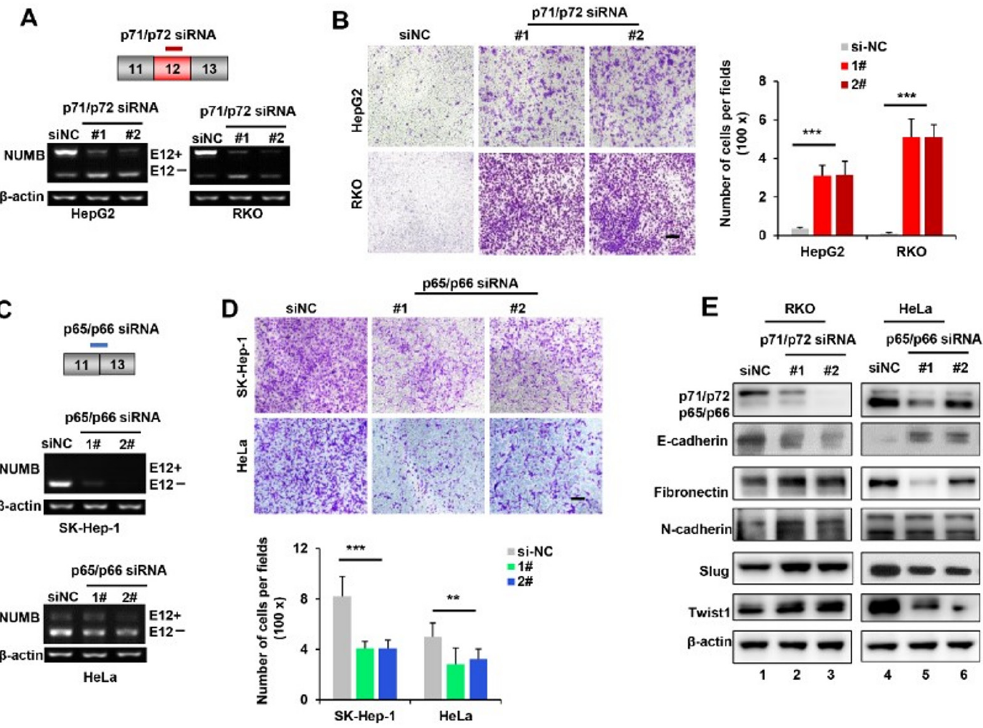
Figure 2. Knockdown of p71/p72 isoforms enhanced cancer cell migration by promoting EMT, whereas knockdown of p65/p66 isoforms inhibited cell migration by reversing EMT. ( A ) Diagram of siRNA targeted against the p71/p72 isoforms (top). Knockdown efficiency was assessed by RT-PCR analysis in HepG2 and RKO cells treated with control siRNA (siNC) and p71/p72 siRNAs (#1 and #2), respectively (bottom). ( B ) Transwell migration assays were performed using cells described in ( A ). Representative images of migratory cells stained with crystal violet were shown. Scale bar is 200 μ m. The number of migratory cells was quantified, and results are shown as mean ± SD on the right bar graph. ( C ) Diagram of siRNA targeted against the p65/p66 isoforms (top). Knockdown efficiency was assessed by RT-PCR analysis in SK-Hep-1 and HeLa cells treated with siNC and p65/p66 siRNAs (#1 and #2), respectively (middle and bottom). ( D ) Transwell migration assays were performed with cells described in ( C ). Representative images of migratory cells stained with crystal violet were shown on the top. Scale bar is 200 μ m. The number of migratory cells was quantified, and results are shown as mean ± SD on the bottom. ( E ) Western blot analysis was performed using whole-cell lysates isolated from RKO and HeLa cells described in ( A , C ). ** p < 0.01, *** p < 0.001.